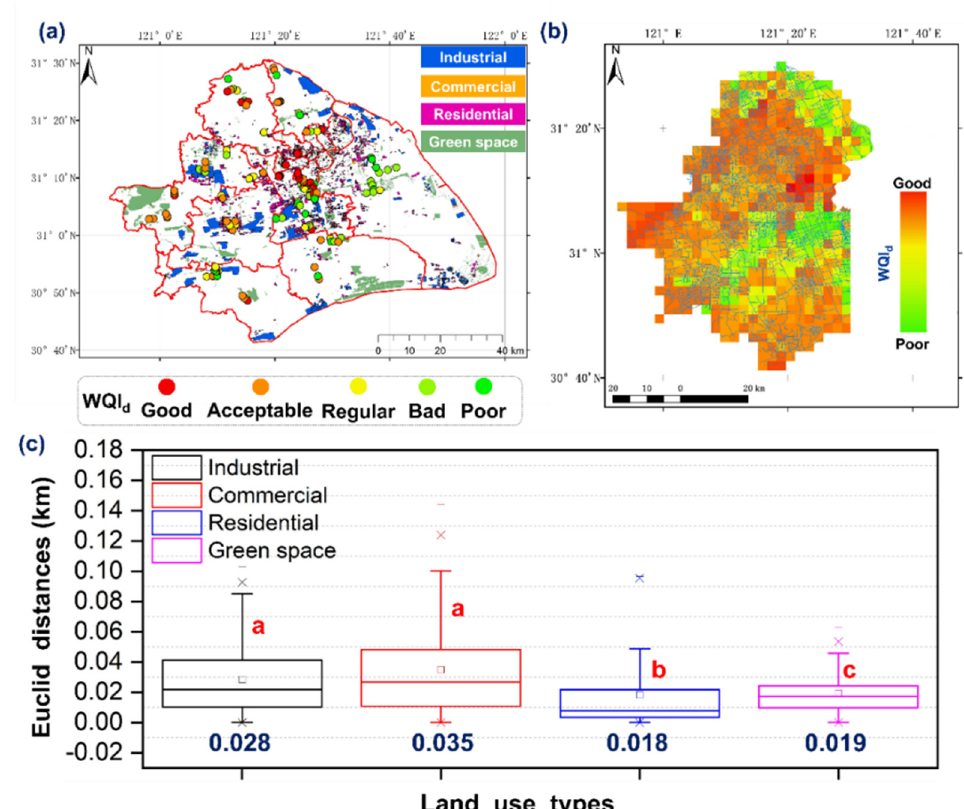
Figure 2. ( a ): Map layers illustrating the summertime data driven water quality index (WQI d ) and four land use type layers in Shanghai. ( b ): Map indicates spatially extrapolated WQI d with 0.025 decimal degree resolution using Kriging regression according to the in situ measurements from sampled small- and medium-sized river sections during late summer. ( c ): Landscape Euclidean distance between sampled rivers and surrounded land-use types. Spatially extrapolated WQI d in Shanghai’s Pudong district is omitted due to limited samples. Box charts in ( c ) are tagged with the intragroup averaged Euclidean distance. The Duncan’s multiple range test (a-b-c) shows Euclidean distances across four land-use types are significantly different ( p < 0.05). Table 1. Fixed effects of human settlements on summertime WQI d in Shanghai’s small- and medium- sized rivers. Statistical method: an analysis of variance procedure using Tukey’s Honestly